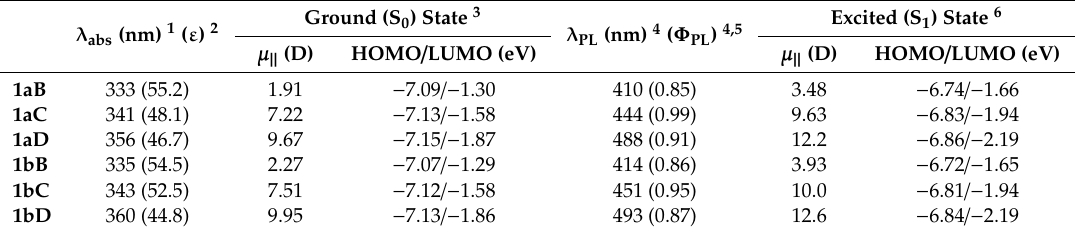
Table 1. Photophysical data for 1aB – D and 1bB – D in CH 2 Cl 2